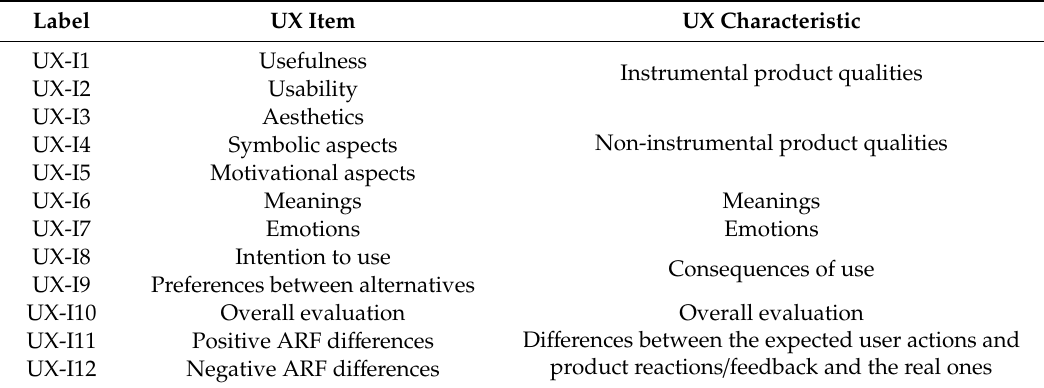
Table 1. The twelve user experience (UX) items exploited in this